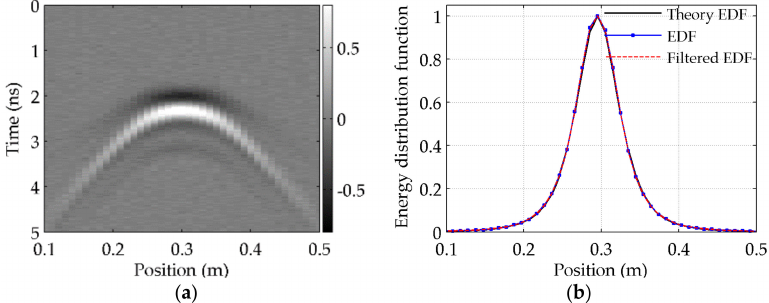
Figure 3. Numerical experimental data with a single scatter. ( a ) presents the radargram of the target. Note that the direct wave is canceled with a pre-measured reference background signal. ( b ) shows the energy distribution function derived from ( a ), where the direct obtained and filtered energy distribution function (EDF) are illustrated with blue-dot and red-dash lines respectively. For comparison, the black line presents the theoretical value.